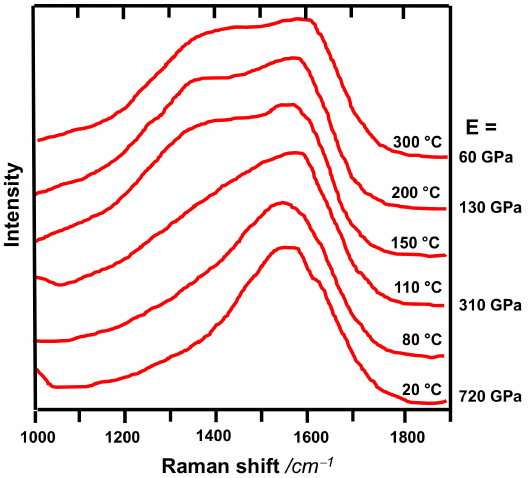
Figure 23. Raman spectrum of carbon films deposited by cathodic Laser-Arc without bias for various substrate temperatures [62].